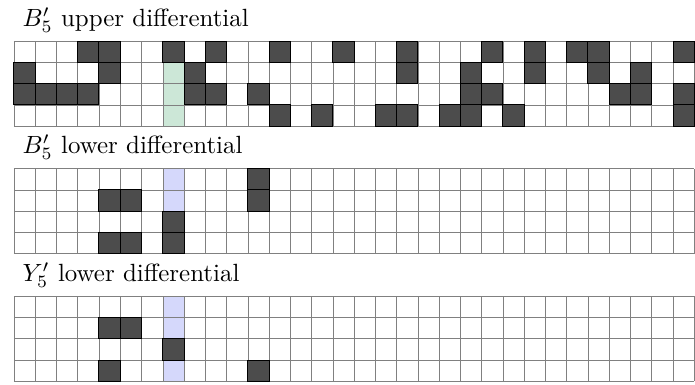
Figure 3: Differences involved in our analysis of the amplified boomerang attack on Serpent [KKS00]. Black bits are active, and the green and blue column marks S-box 24 in the upper and lower differential